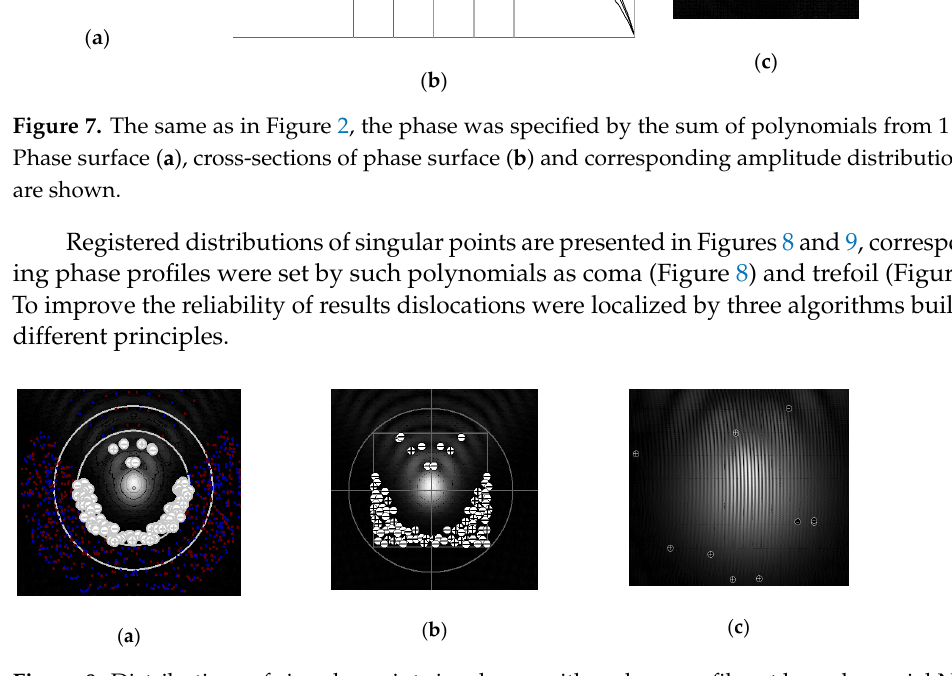
( c ) Figure 9. The same as in Figure 8, but the phase was specified by polynomial No. 9 (trefoil). N dsl = 58 ( а ), N dsl = 43 ( b ) и N dsl = 7 ( c ). The dependence of dislocation quantity on polynomial number is shown in Figure 10. The radius of a region where detection was performed changed in the range from 1 to 1.4 initial radii of a beam. Figure 10. Number of singular points ( N dsl ) in a beam wavefront with a phase specified by different polynomials ( N z ). Registration was carried out in a region with a radius equal to the initial radius of a beam (curve 1), to two initial radii (2), to three initial radii (3). Z = 0.1. The number of the found vortices as a function of the distance traveled by a beam is presented in Figures 11 and 12. The initial phase was formed by such polynomials as coma and trefoil (Figure 11) or set by a phase screen representing atmospheric turbulence (Equation (1)).